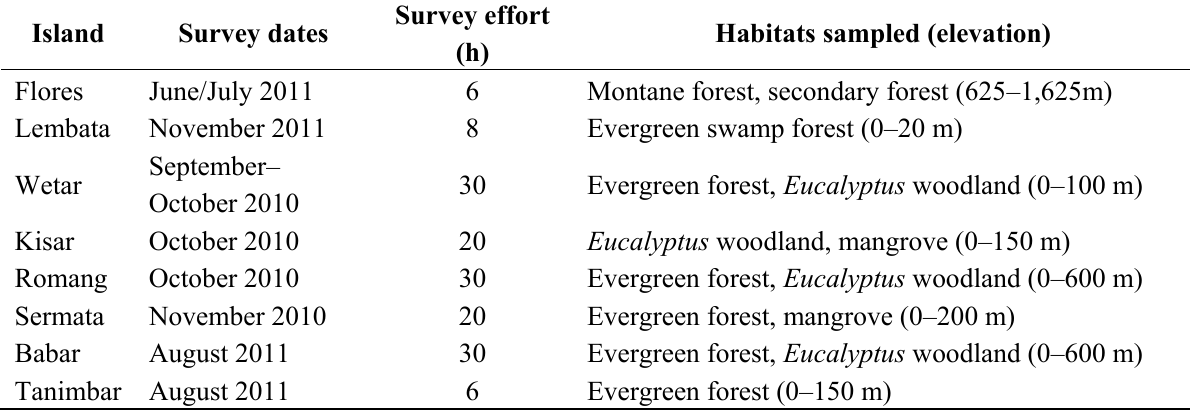
Table 1. Summary of supplementary sampling of Polyrhachis species, in addition to that described in